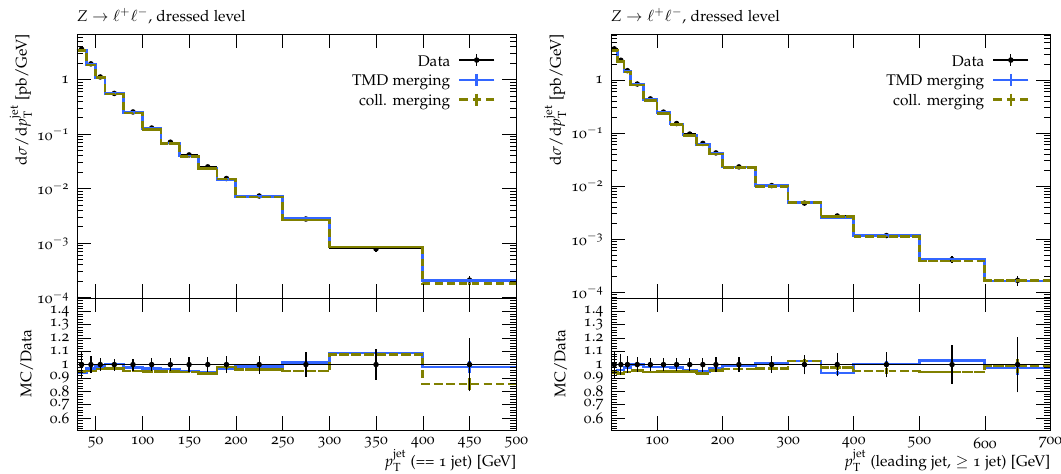
Figure 24 . Predictions obtained using Madgraph + Pythia 6 with MLM merging and the TMD merging framework are compared for exclusive (left) and inclusive (right) leading jet p the production of a Z -boson in association with jets. The phase space for the calculation follows the one in